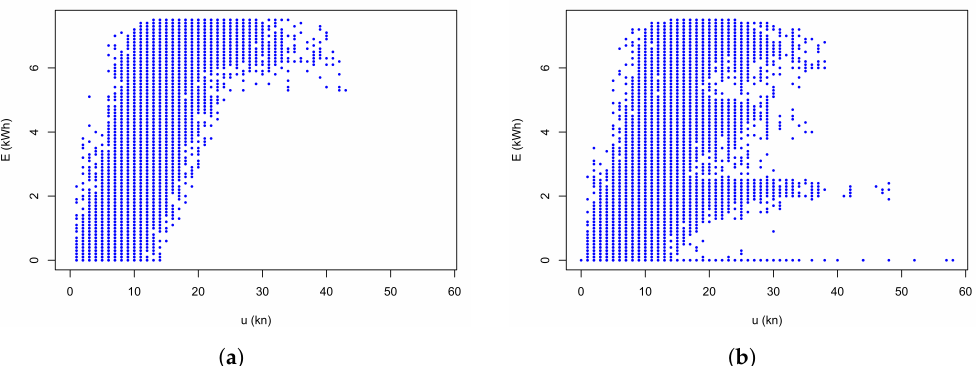
Figure 1. Scatter plot of electricity production against wind speed at a distance of 25 km, ( a ) Training data for the training period, and ( b ) Validation data for the validation period.